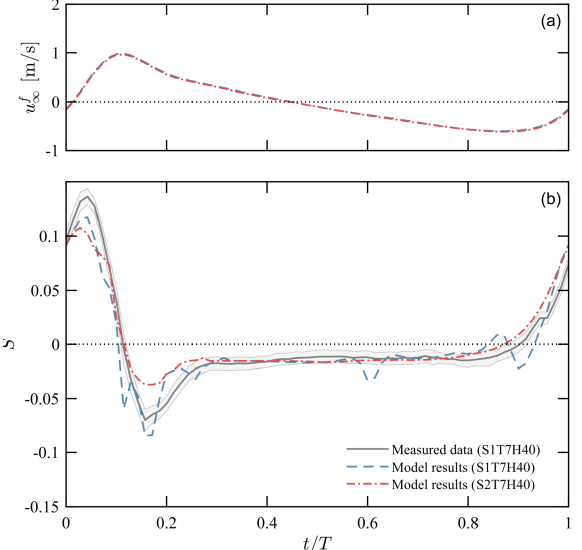
Figure 9. Time series of ( a ) modeled free stream velocity (blue dashed curve, S1T7H40; red dash–dot curve, S2T7H40) and ( b ) Sleath parameter, S , from measured data for S1T7H40 (gray solid curve, phase-averaged; gray envelope, ± 1 standard deviation) and model results (blue dashed curve, S1T7H40 at z ∗ = − 6.8 mm; red dash–dot curve, S2T7H40 z ∗ = − 6.4